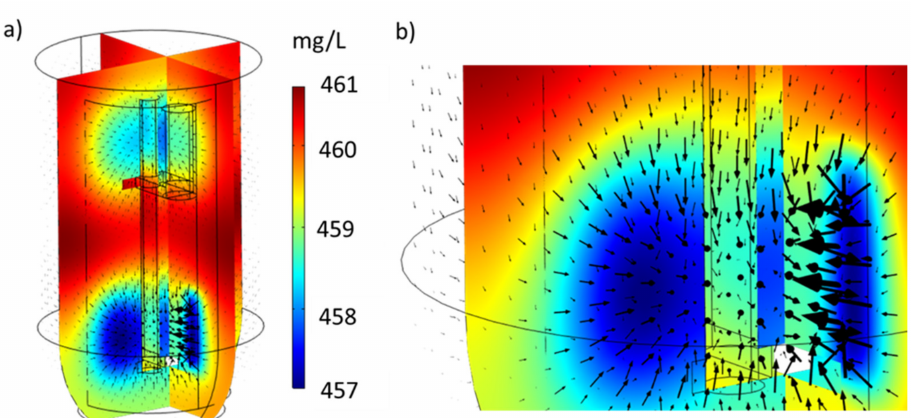
Figure 10. ( a ) Concentration profile and mass fluxes. ( b ) Zoom in the lower ACC. Agitation rate = 100 RPM, initial concentration = 487 mg/L, simulation time = 1 min.